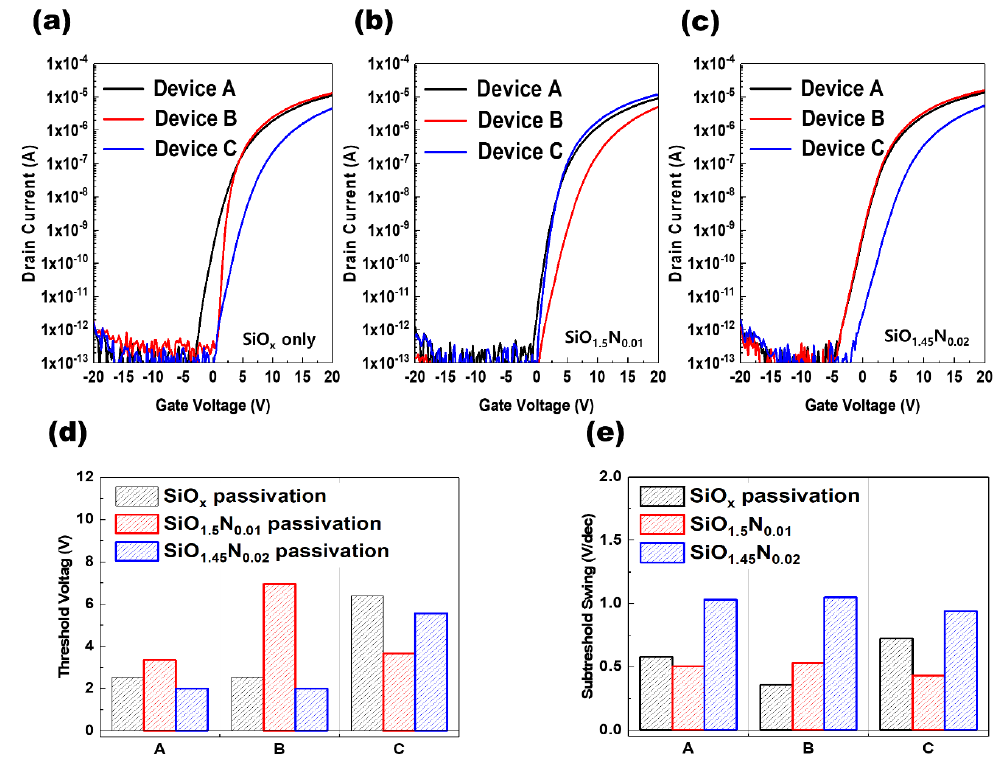
Figure 2. Electric transfer curves of a -IGZO TFTs with passivation by ( a ) SiO x , ( b ) SiO 1.5 N 0.01 , and ( c ) SiO 1.45 N 0.02 . Summary of the ( d ) threshold voltage and ( e ) subthreshold swing.